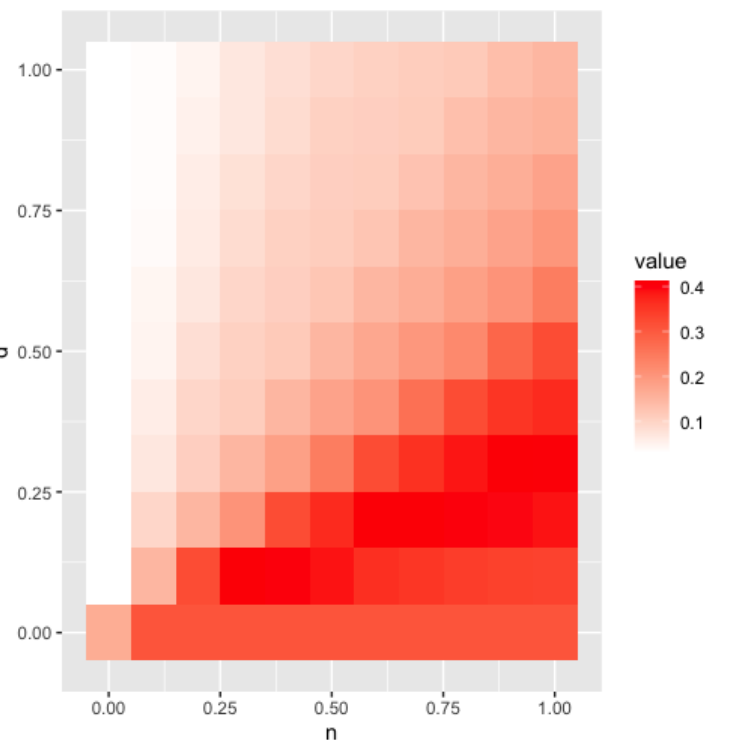
Figure 5. Heatmap for JM1 for different d and n values in strategy 2.